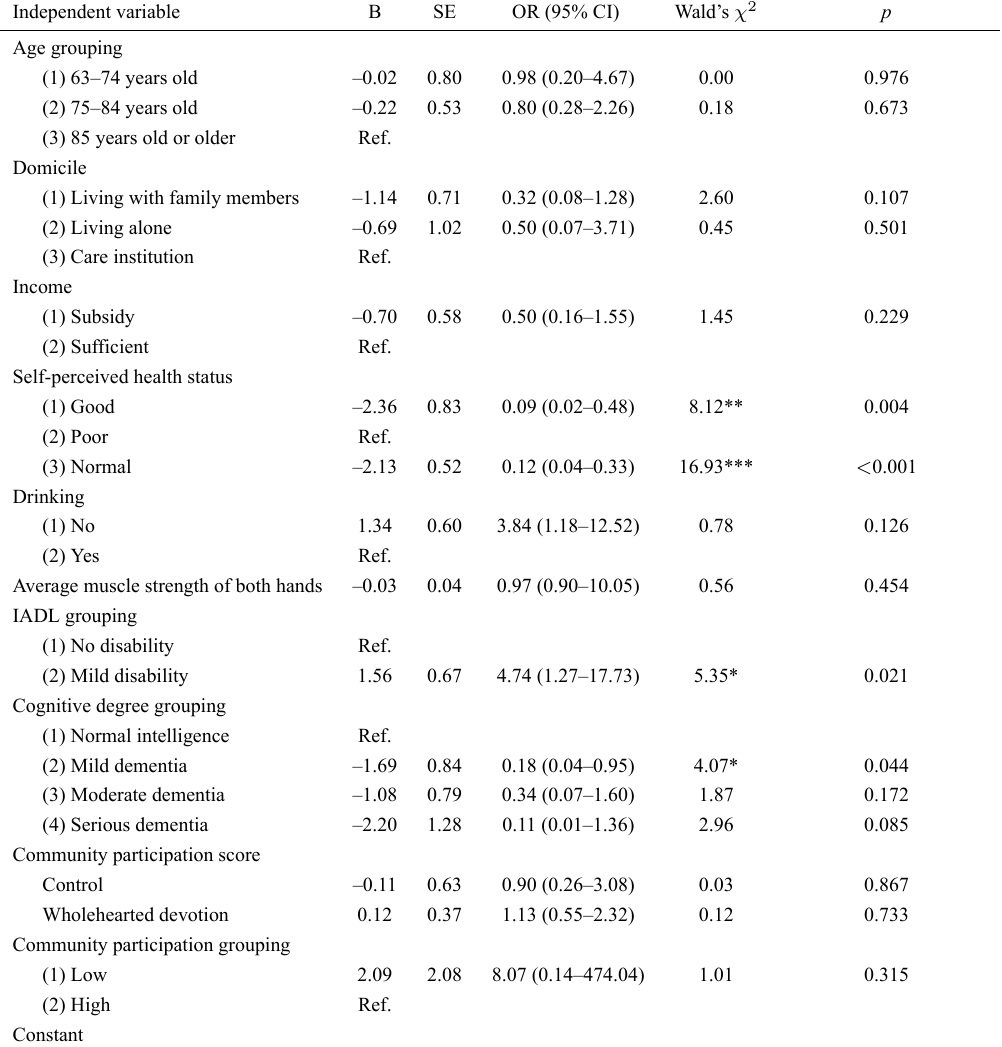
Table 3. Predictors affecting mental health state of elderly men with